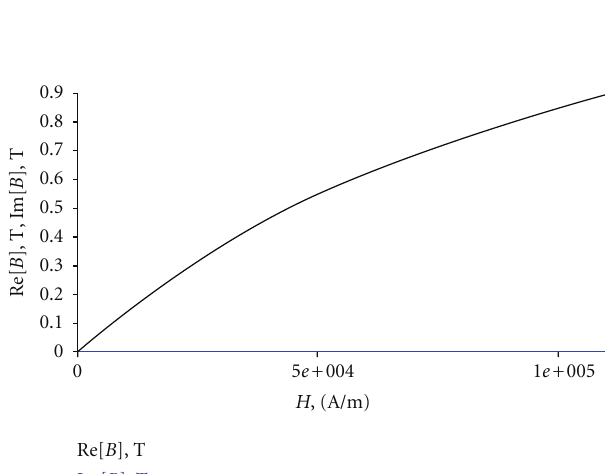
Figure 6: Stator nonlinear B-H